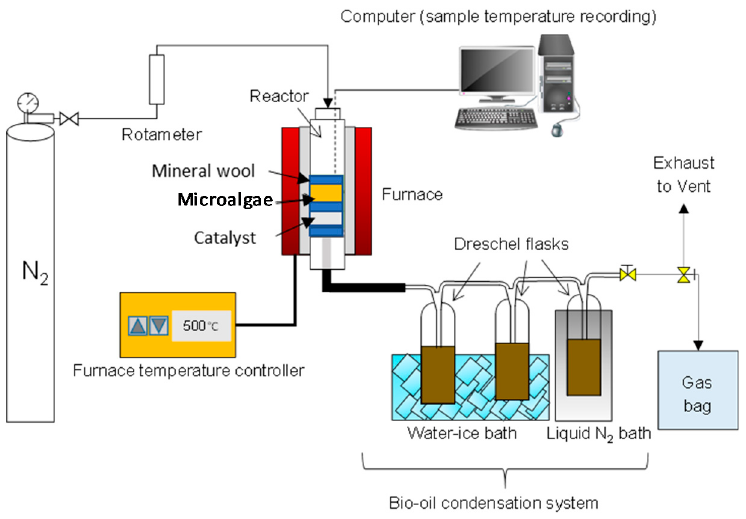
Figure 1. Schematic diagram of the catalytic pyrolysis setup.